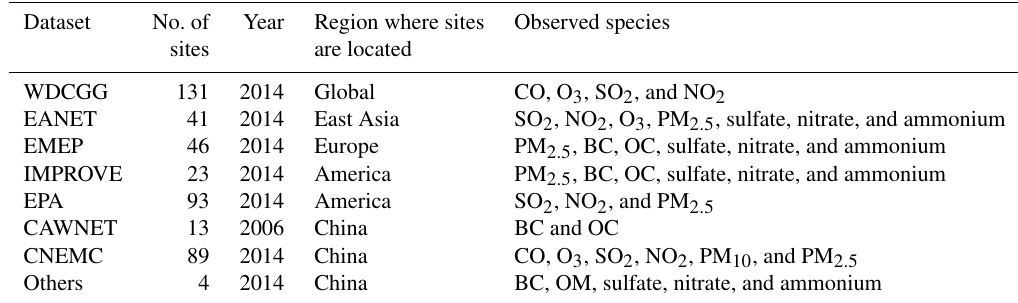
Table 3. Summary of the site observation datasets.